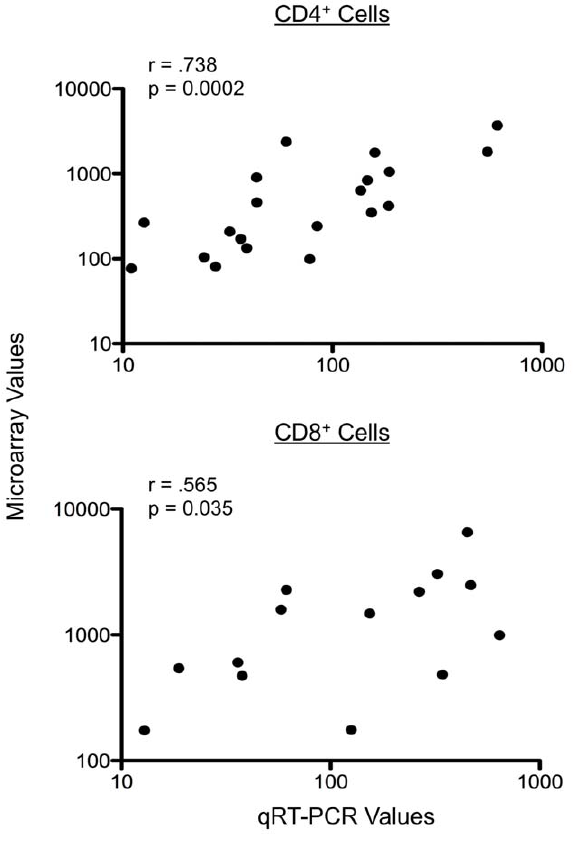
Figure 2. Quantitative RT-PCR and microarray correlation. Correlation between Taqman TM qRT-PCR values and microarray expression values for 10 genes in CD4 + cells (top panel) and 7 genes in CD8 + cells (bottom panel). Each point illustrates the average value of the 3 individuals within each patient group for qRT-PCR (x-axis) vs microarray (y-axis) for the same sample. Quantitative RT-PCR values were calculated as the antilog of ([1/ D CT] 6 100) where D CT=cycle threshold (CT) of the test gene minus the CT of the 18S ribosomal gene; microarray values are the antilog of the intensity values imported from GenePix. The Spearman Rank Correlation was used to calculate r- and p- values. Data associated with these plots are shown in Table S1.